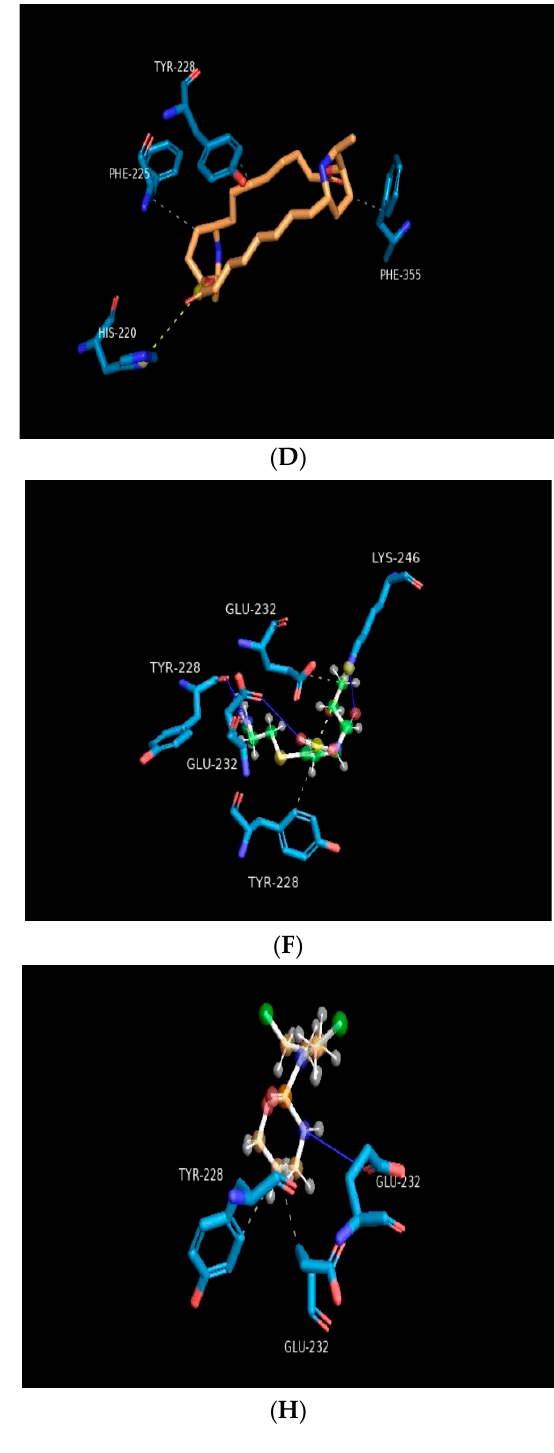
Figure 2. Molecular docking of compounds with surfactant protein D (PDB ID: 1PW9): ( A ) 2D schematic diagram showing interactions of quercetin. ( B ) Cartoon view of surfactant protein D with quercetin. ( C ) 2D schematic diagram showing interactions of carpaine. ( D ) Cartoon view of surfactant protein D with carpaine. ( E ) 2D schematic diagram showing interactions of imipenem (standard). ( F ) Cartoon view of surfactant protein D with imipenem (standard). ( G ) 2D schematic diagram showing interactions of cyclophosphamide (standard). ( H ) Cartoon view of surfactant protein D with cyclophosphamide (standard). Residues involved in hydrogen bonding, van der Waals interactions, carbon–hydrogen, and Pi–alkyl are represented in different colours indicated in the inset.